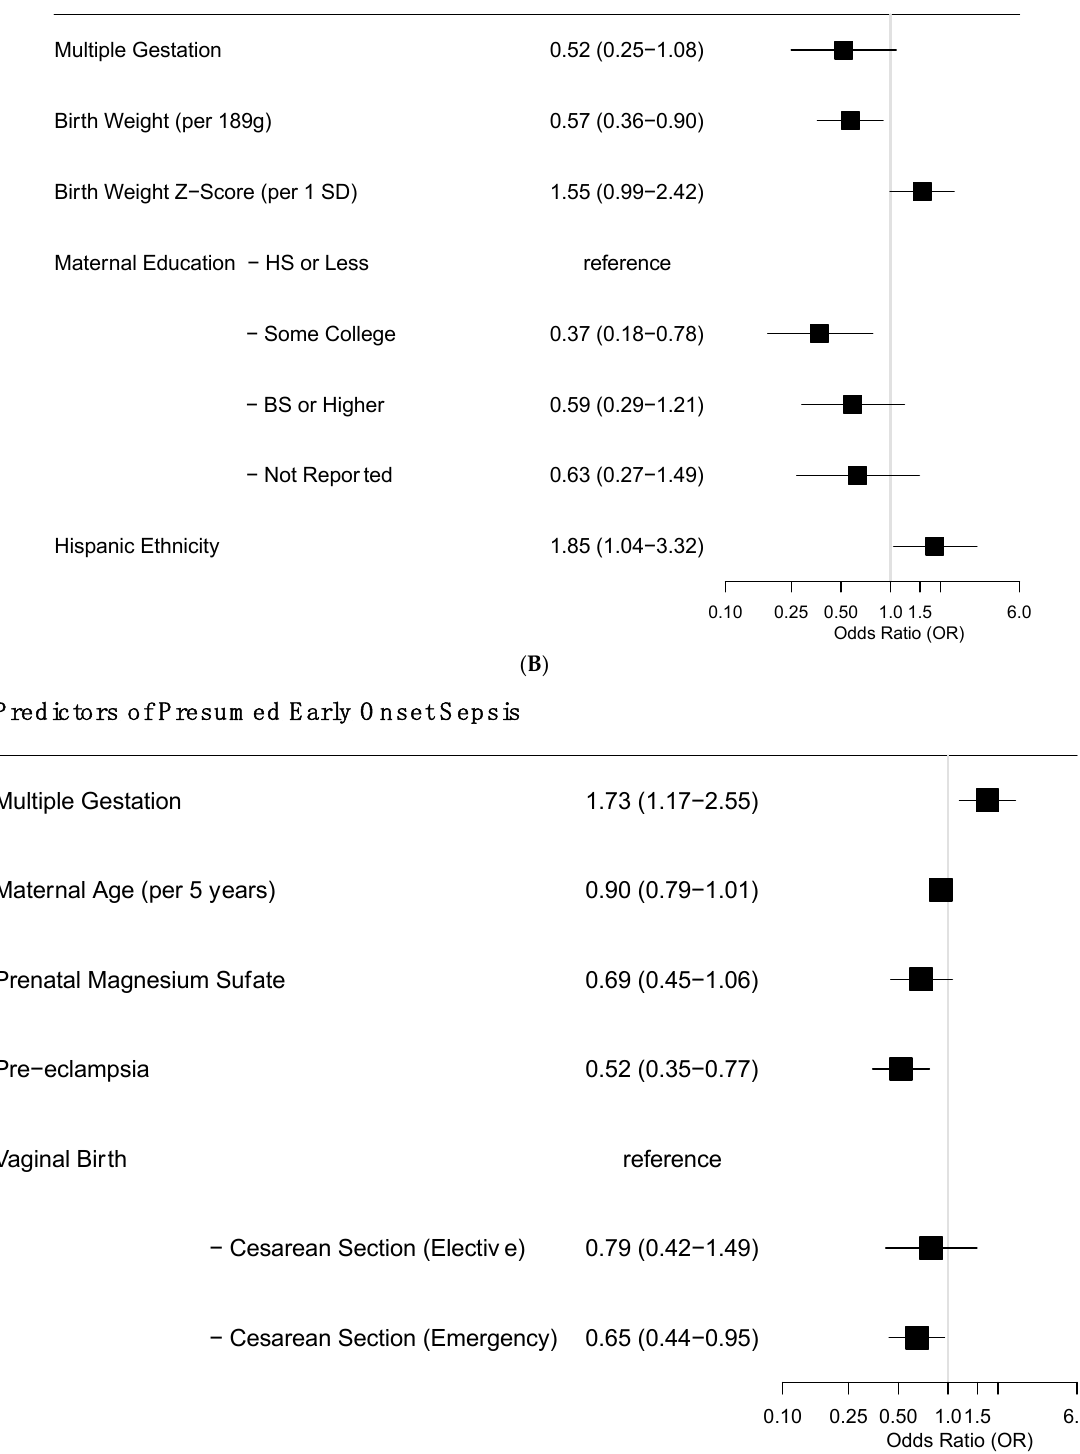
Figure 2. This is a figure. Forest plot of predictors of confirmed ( A ) and presumed ( B ) early onset sepsis. In this independent, multivariable association, significant differences were noted for birth- weight, maternal education, and Hispanic ethnicity for confirmed early onset sepsis ( A ); significant di ff erences were noted for multiple gestation, pre-eclampsia and emergent cesarean section for presumed early onset sepsis ( B ).